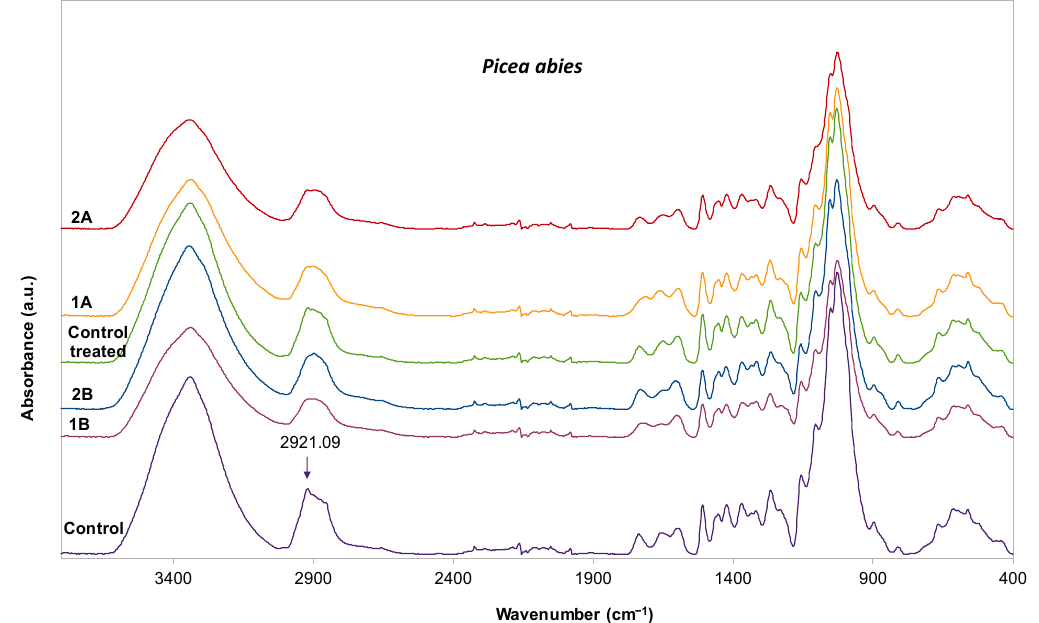
Figure 5. Spectral band assignments of the main spectral peaks observed in the Norway spruce wood FTIR spectra. 1A—